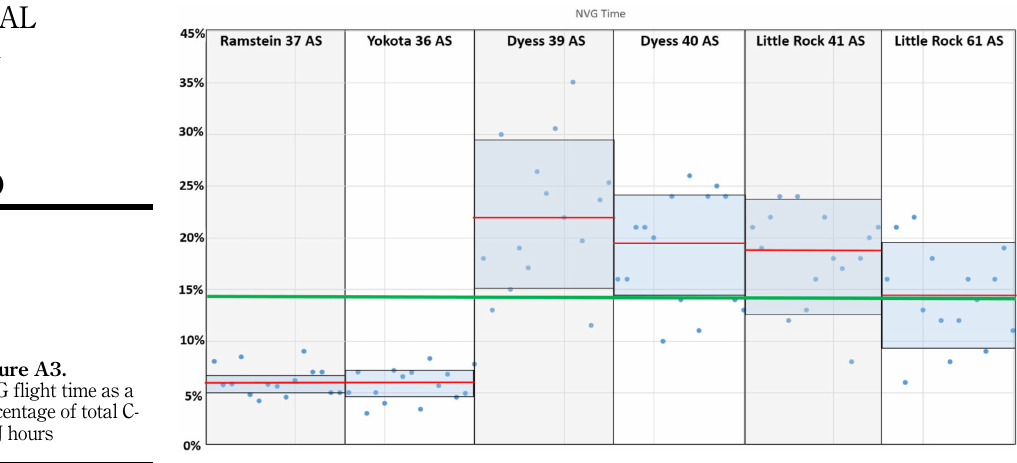
Figure A3. NVG flight time as a percentage of total C- 130J